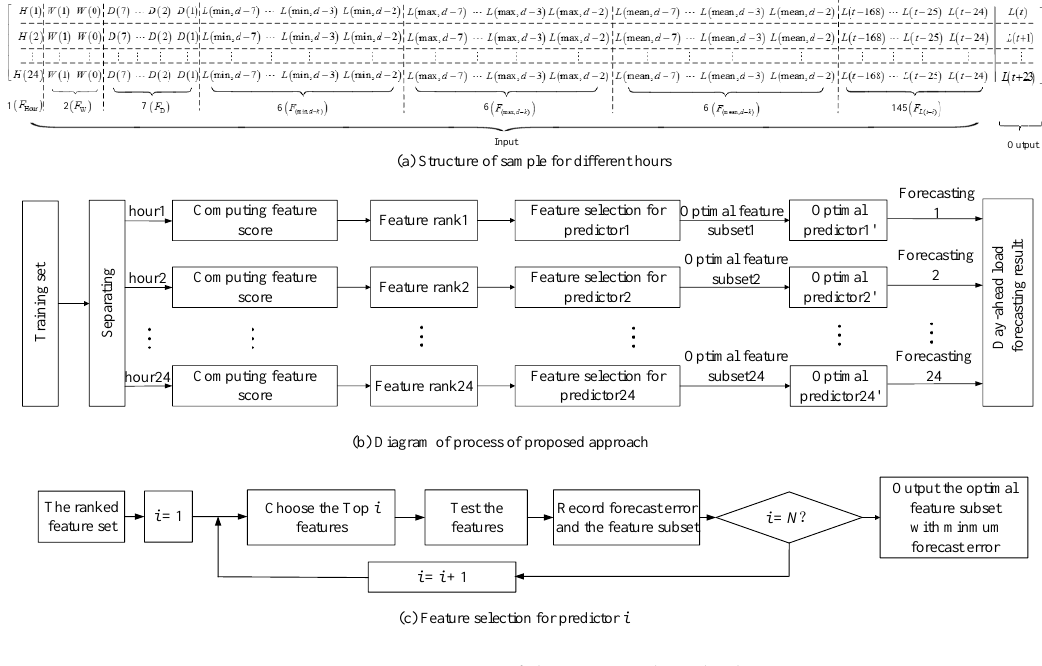
Figure 2. Overview of the proposed method.